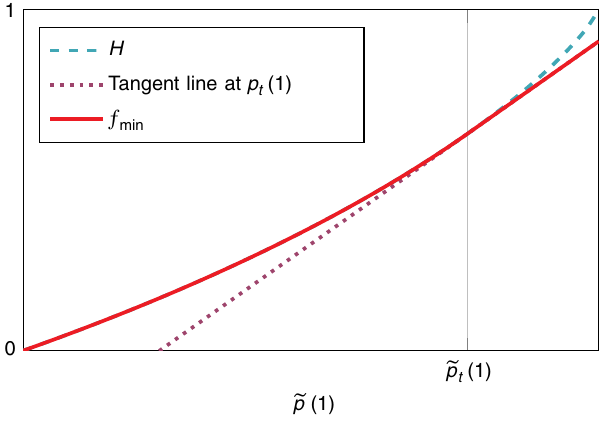
Fig. 6 The construction of the min-tradeoff function f min . The plot shows the values of the min-tradeoff function on a slice ~ p ð 0 Þ þ ~ p ð 1 Þ ¼ 1 (cid:2) ð 1 (cid:2) γ Þ s max